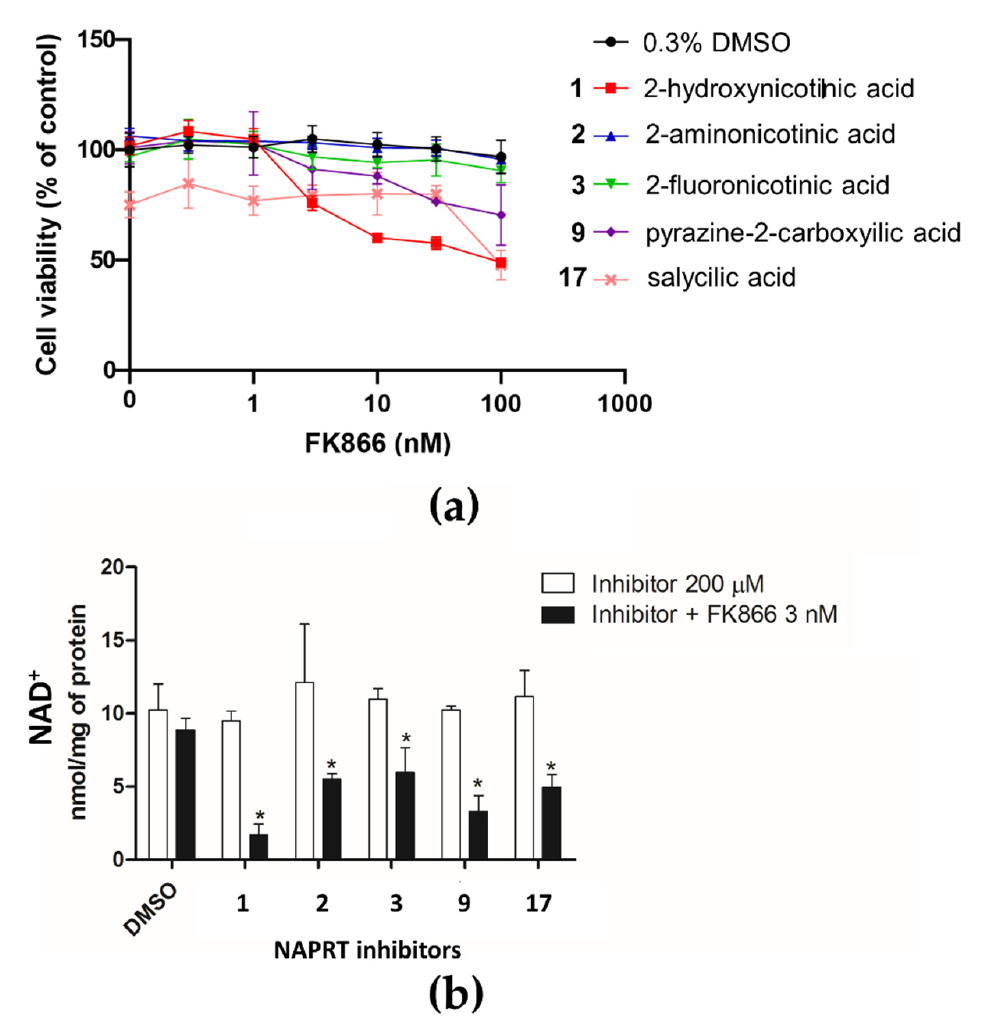
Figure 5. Effects of NAPRT inhibitors on OVCAR-5 cells viability and NAD + content. ( a ) OVCAR-5 cells were incubated with selected compounds at 200 µ M with or without the addition of different concentrations of FK866 for 72 h. Cell viability was determined using the sulforhodamine B assay. Data are mean ± SD of three experimental replicates. ( b ) OVCAR-5 cells were treated with selected compounds at 200 µ M with or without 3 nM FK866. After 24 h, intracellular NAD + levels were measured. Data are mean ± SD of three experimental replicates. * p < 0.05. Except for salicylic acid ( 17 ), the tested compounds did not modify cell viability in the absence of FK866, as cells rely on the NAMPT enzyme to produce NAD + from the nicotinamide present in the culture medium. In this view, the toxicity of salicylic acid ( 17 ) might be due to a nonspecific activity. While 2-aminonicotinic acid ( 2 ) and 2-fluoronicotinic acid ( 3 ) did not significantly sensitize cells to FK866 toxicity, 2-hydroxynicotinic acid ( 1 ) and pyrazine-2-carboxylic acid ( 9 ) reduced cell viability when combined with FK866. A com- bination index analysis performed on the cell viability curves demonstrated a synergistic effect of these compounds with FK866 (Table